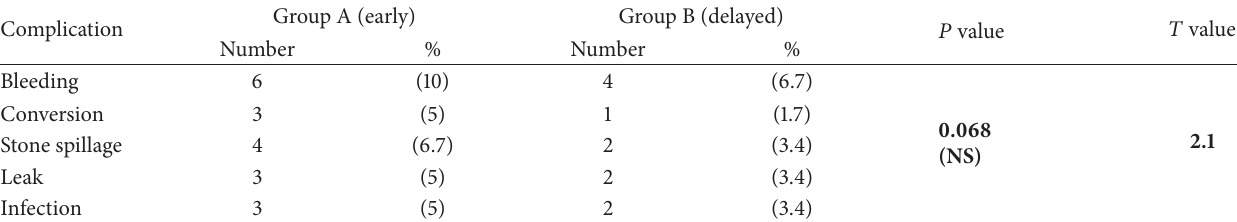
Table 2: Operative and postoperative complications in both groups.